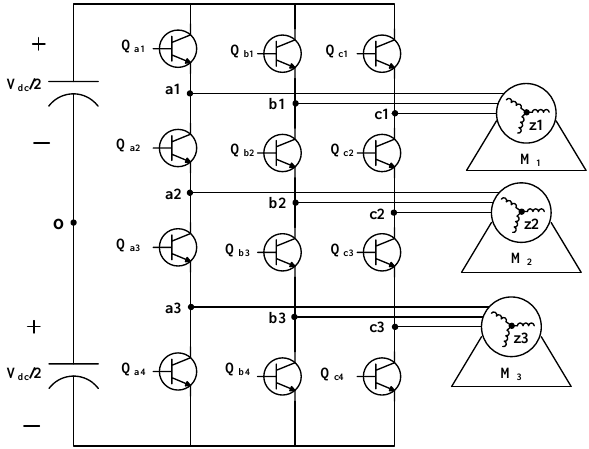
Figure 1: Structure of the 12 -switch